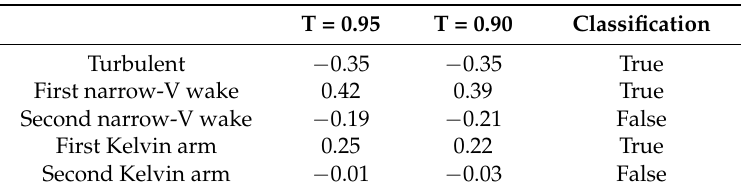
Table 1. Merit index estimated along the detected wake features discarding 10% to 5% of brighter pixels (T = 0.95 and 0.90).